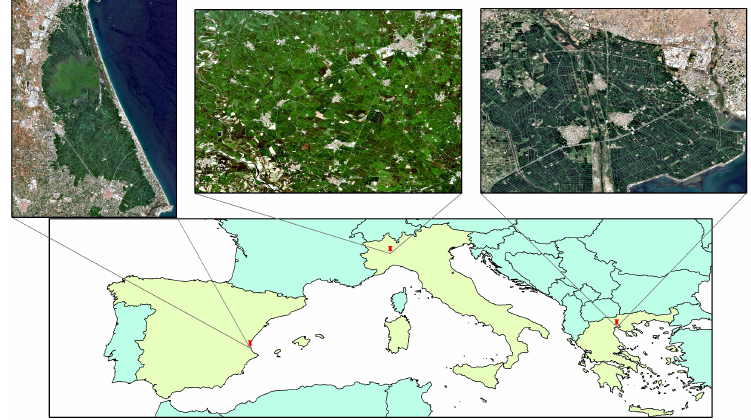
Figure 1. Study areas. Sentinel-2A surface reflectance RGB composite of the Spanish (30 July 2016), Italian (21 July 2016) and Greek (23 July 2016) study